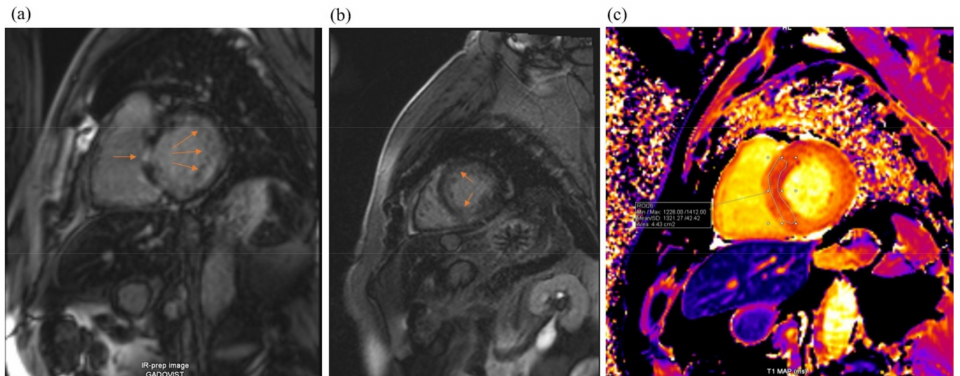
Figure 4. Cardiac magnetic resonance imaging: LV hypertrophy with diffuse subendocardial late gadolinium enhancement (arrowheads, pictures ( a , b )) and some zones of focal late gadolinium enhancement (arrow, picture ( c )). T1 mapping shows markedly increased values (1321